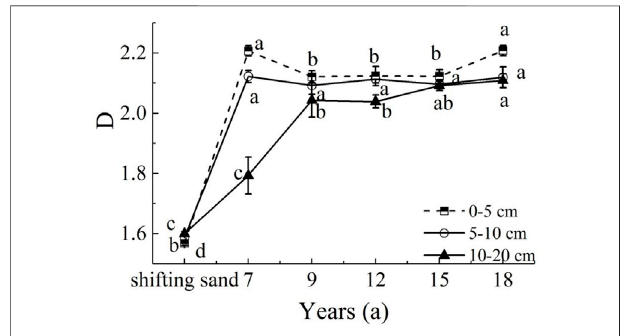
FIGURE 7 | Changes of D of PSD in shelterbelt soil of different forest ages (Wang et al., 2018).